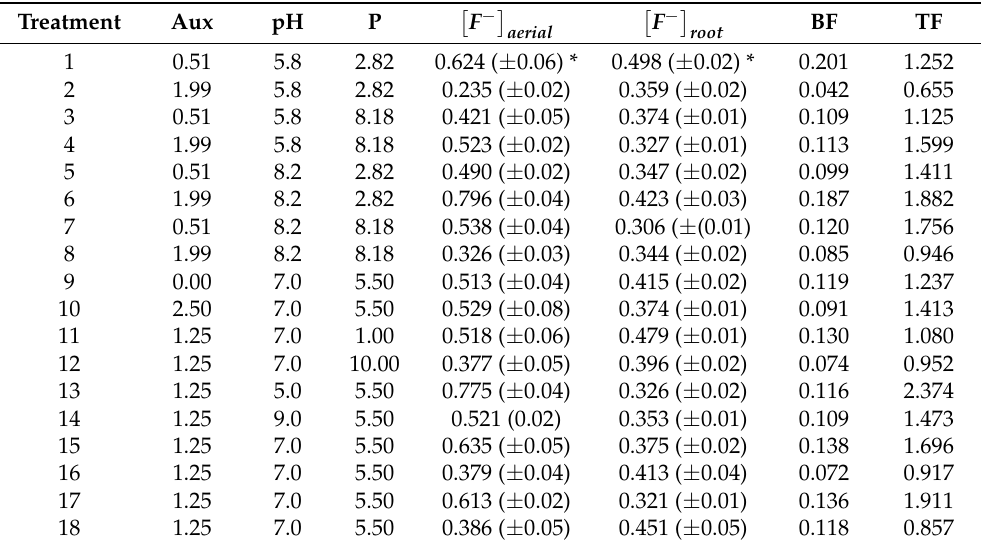
Table 7. Fluoride contents in plant tissues (cid:4670) 𝐹 − (cid:4671) mulation factor (BF) (Equation (4)), and translocation factor (TF) (Equation (5)) of E. crassipes ex- posed to 15 mg L − 1 of fluoride for 10 days.